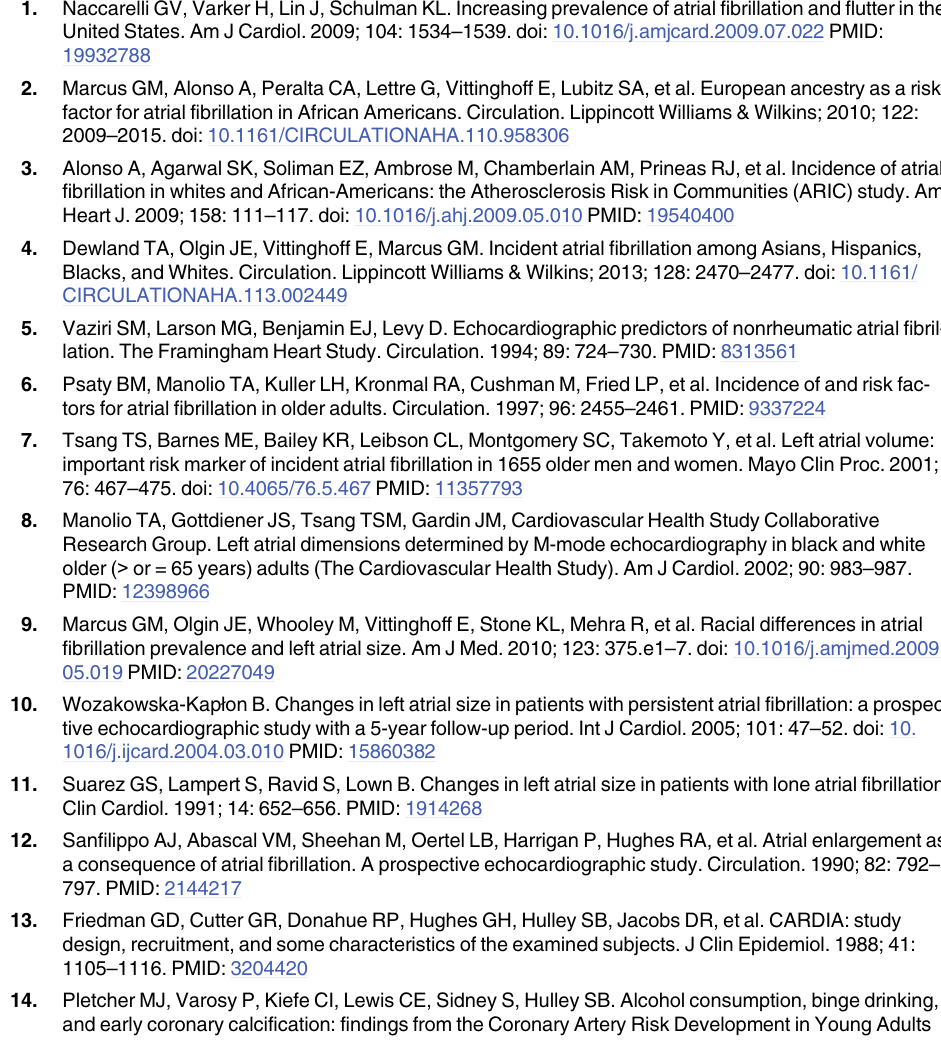
S1 Table. Association Between European Ancestry and Left Atrial